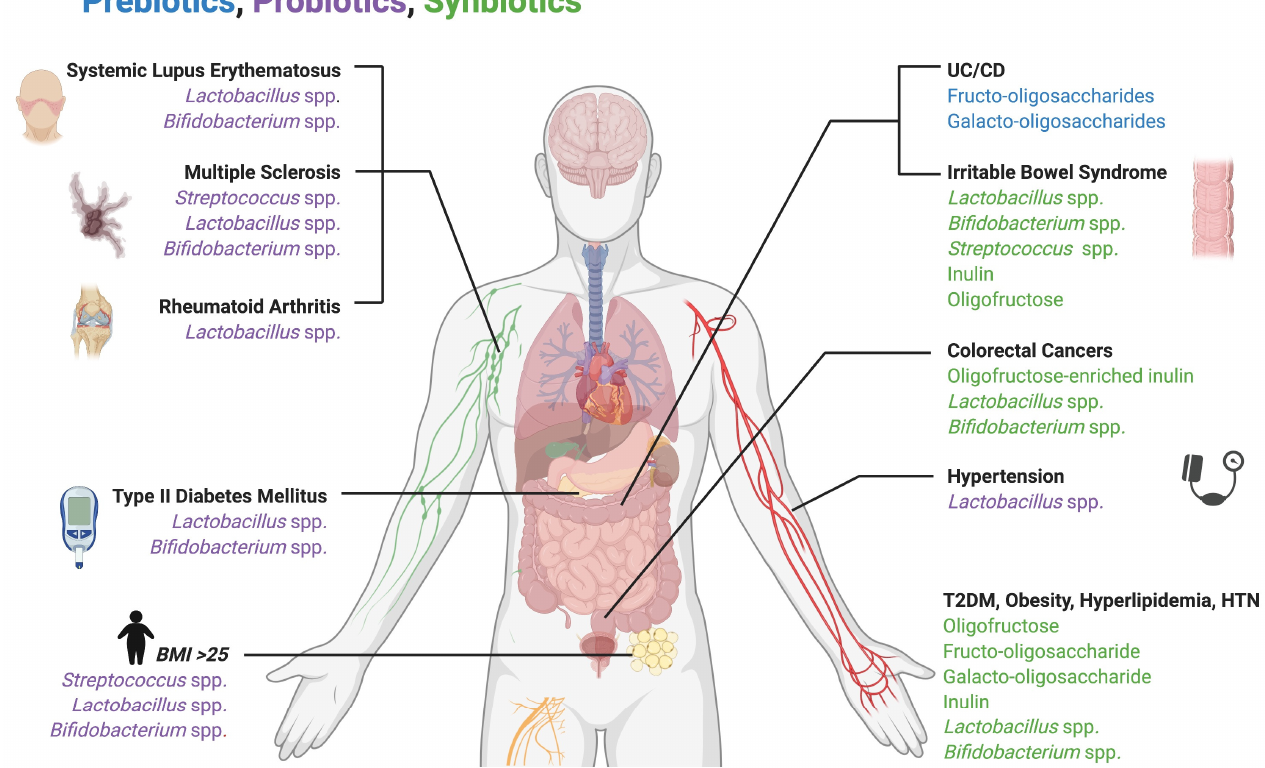
Figure 2. Use of prebiotics, probiotics, and synbiotics as therapeutic strategies for the reversal of microbial dysbiosis. Numerous bacterial species and dietary substrates have been shown to therapeutically shift microbiota composition and alleviate the symptoms and biomarkers of systemic